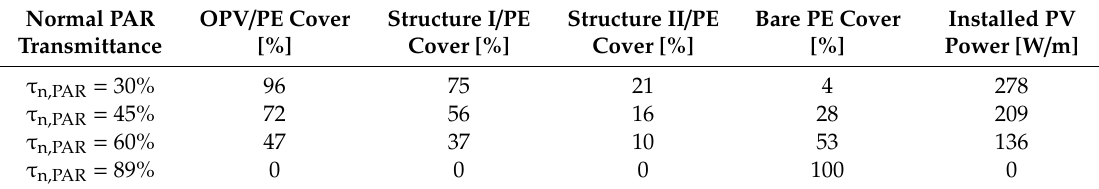
Table 8. Examined OPV / cover